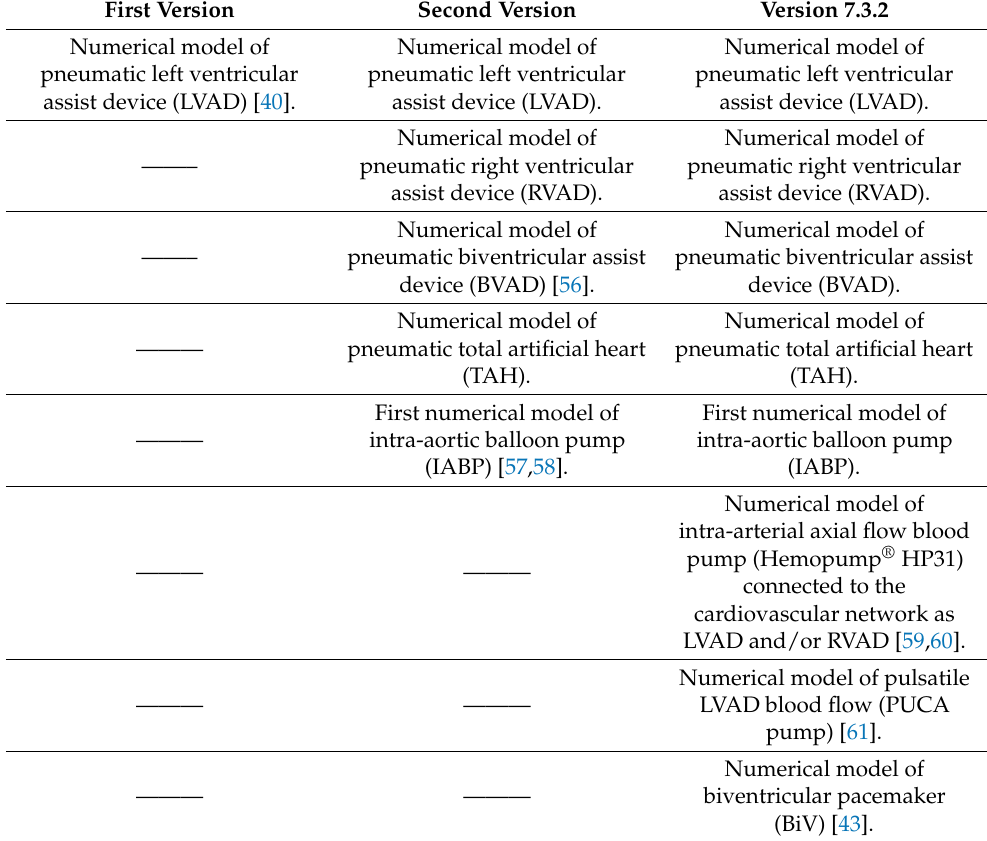
Table 4. Evolution over time of numerical models of mechanical circulatory assist